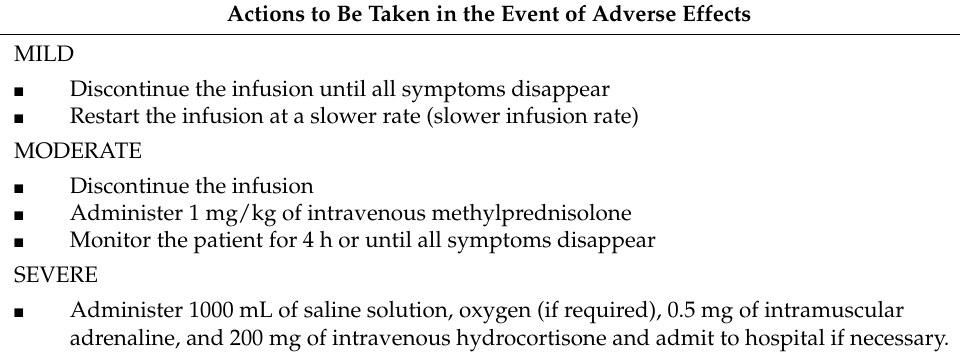
Table 7. Actions to be taken in the event of adverse